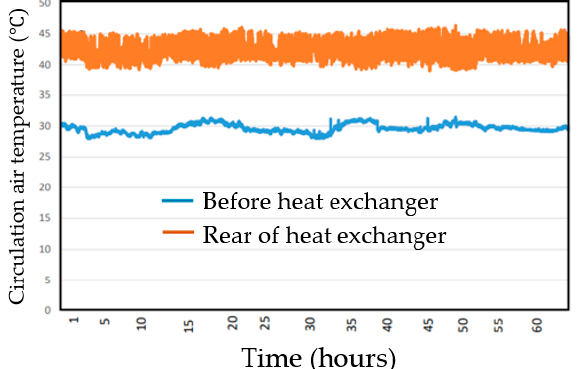
Figure 7. Circulating air temperature difference before and the rear of the heat exchanger connecting the third heat pump in experiments.